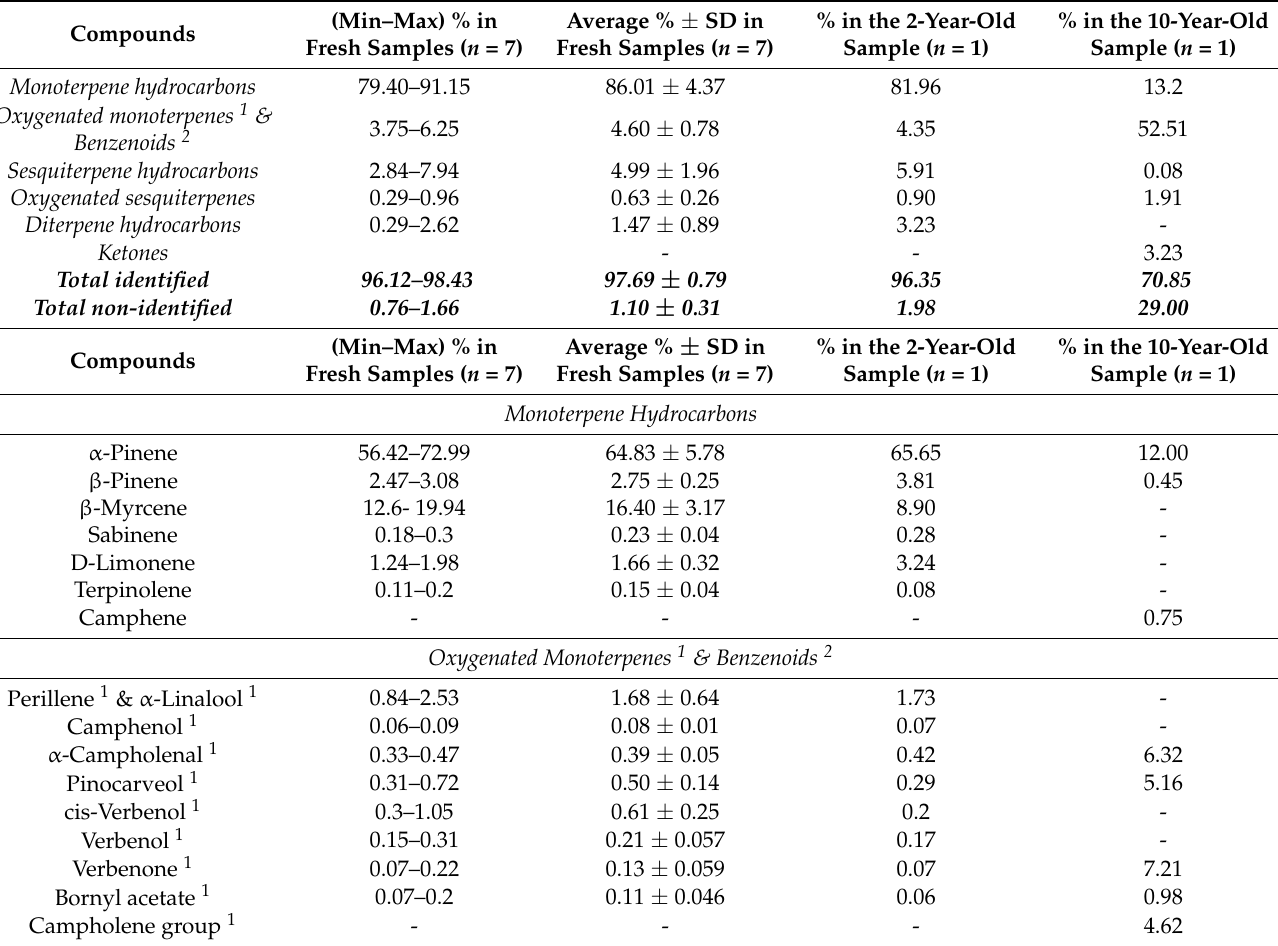
Table 3. CMO chemical composition in fresh (CMO_1-7), aged for 2 years (CMO_8) and aged for 10 years (CMO_9) samples